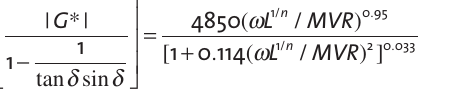
Figure 15 (left above): Uni- fied curve of the new speci- fication parameter |G*|/(1 – (1/tan d sin d )) with modi- fied frequency w (L1 / n /MVR) at temperatures of 46˚C, 58˚C and 70˚C for asphalt AAB-1 as well as at temperatures of 52˚C and 64˚C for asphalt AAB-2, each in original unaged and (RTFOT & PAV) aged forms. Figure 16a (right above): Plot of the shift factor L1/n/MVR for RTFOT-aged asphalts versus the original unaged asphalts. Figure 16b (left below): Plot of the shift factor L1/n/MVR for PAV-aged asphalts ver- sus the original unaged